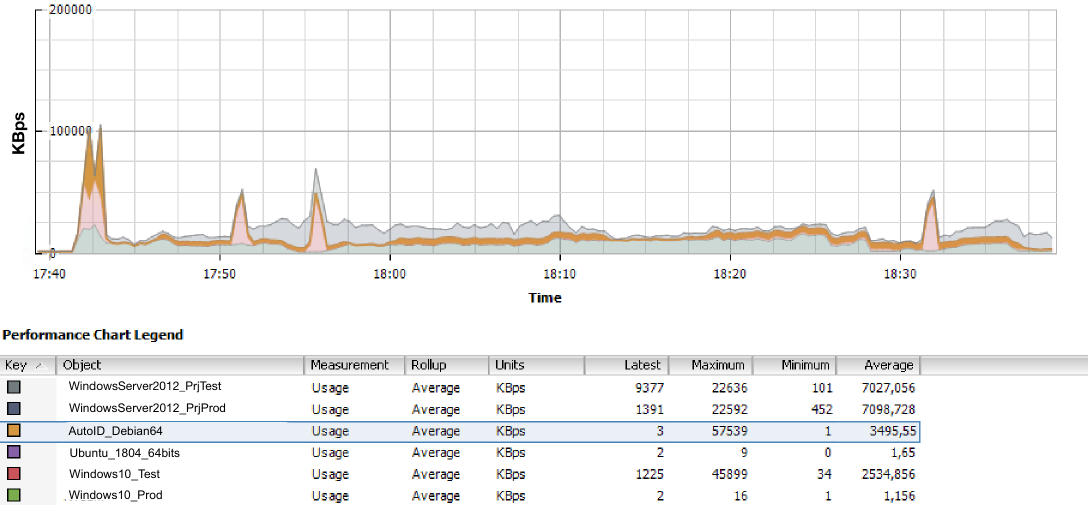
Figure 18. Network usage of the active virtual